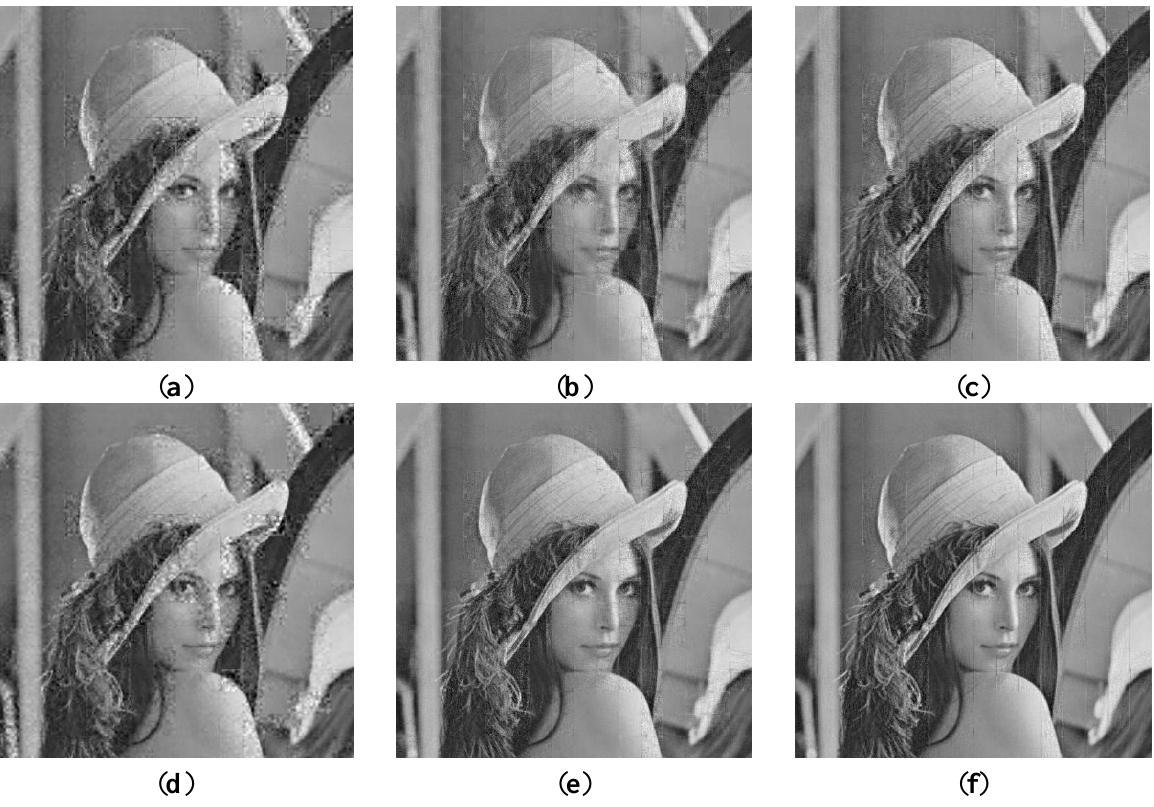
Figure 7. Visual quality comparisons at sensing rate R = 0.2 and R = 0.4 for 512 × 512 “Lena” using the proposed EW-CS, the M-CS [21] and the CS. ( a ) M-CS, R = 0.2, ( b ) Ordinary CS, R = 0.2, ( c ) EW-CS, R = 0.2, ( d ) M-CS, R = 0.4, ( e ) Ordinary CS, R = 0.4, ( f ) EW-CS, R = 0.4.